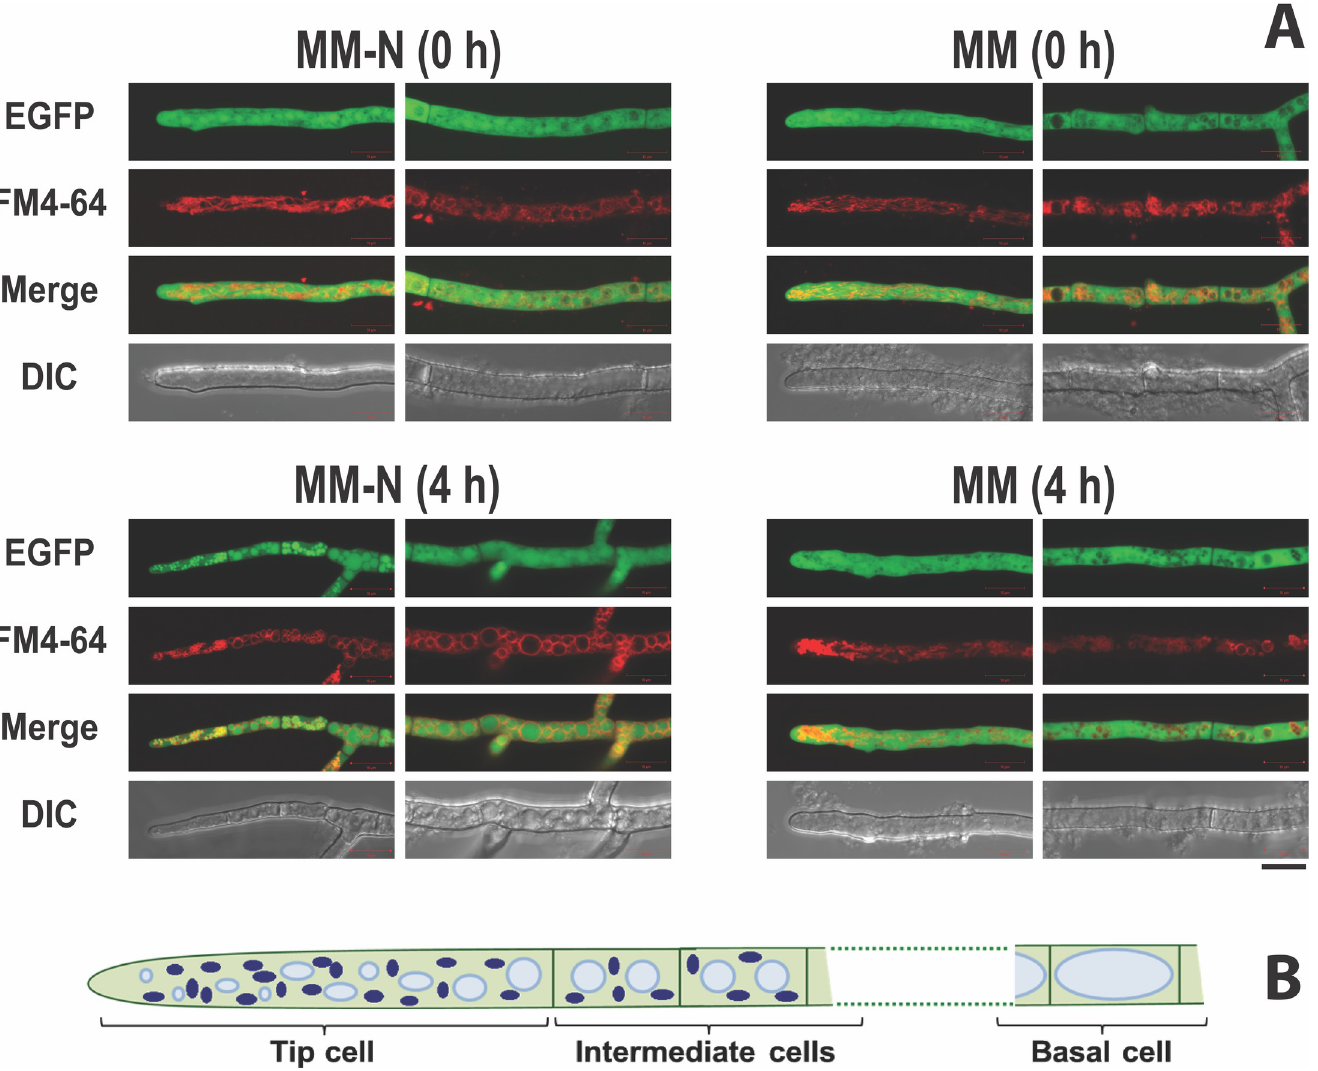
Fig 1. A . niger mycelia respond to nitrogen starvation. (A) The mycelia of A . niger C6JT2 strain grown (up to 20 h) on MM were transferred to MM-N. The EGFP fluorescence of mycelia at the time of transfer (MM-N, 0 h) and after 4 h of N starvation (MM-N, 4 h) was monitored. The corresponding non-starved mycelia control is also shown. In each panel, the left frame shows the image of a tip cell and the right frame is of an intermediate cell. The vacuolar membranes of mycelia were stained red with FM4-64 (scale bar = 10 μ m). (B) Schematic of A . niger hypha. The nuclei (in dark blue), vacuoles (in light blue) and the septa (dark green lines between cells) are shown. The dashed lines represent the connecting intermediate cells up to the basal